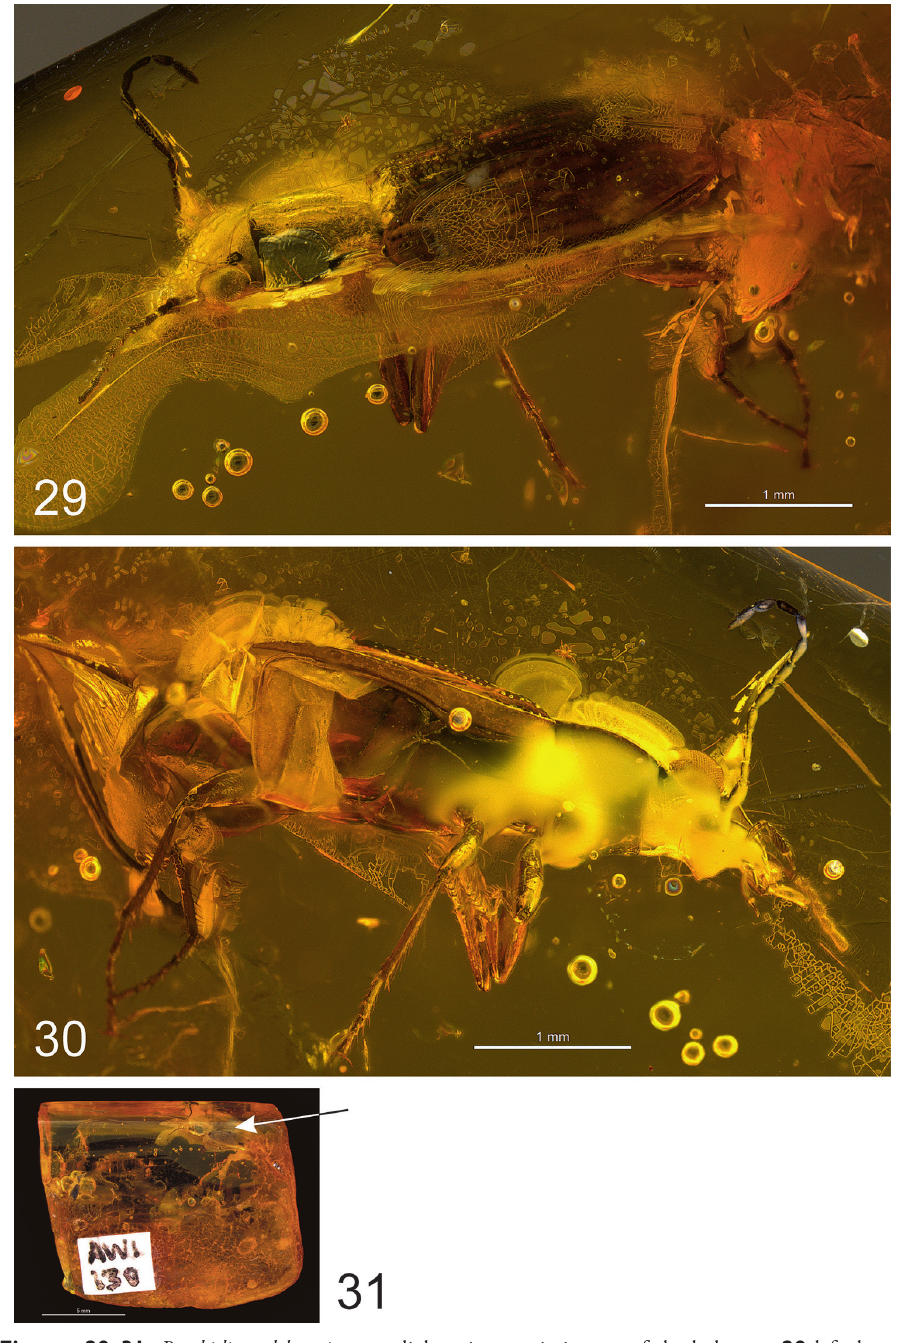
Figures 29–31. Bembidion alekseevi sp. n., light microscopic images of the holotype. 29 left dorso- lateral aspect 30 right ventro-lateral aspect 31 general view of the amber piece; the position of the fossil is marked by an